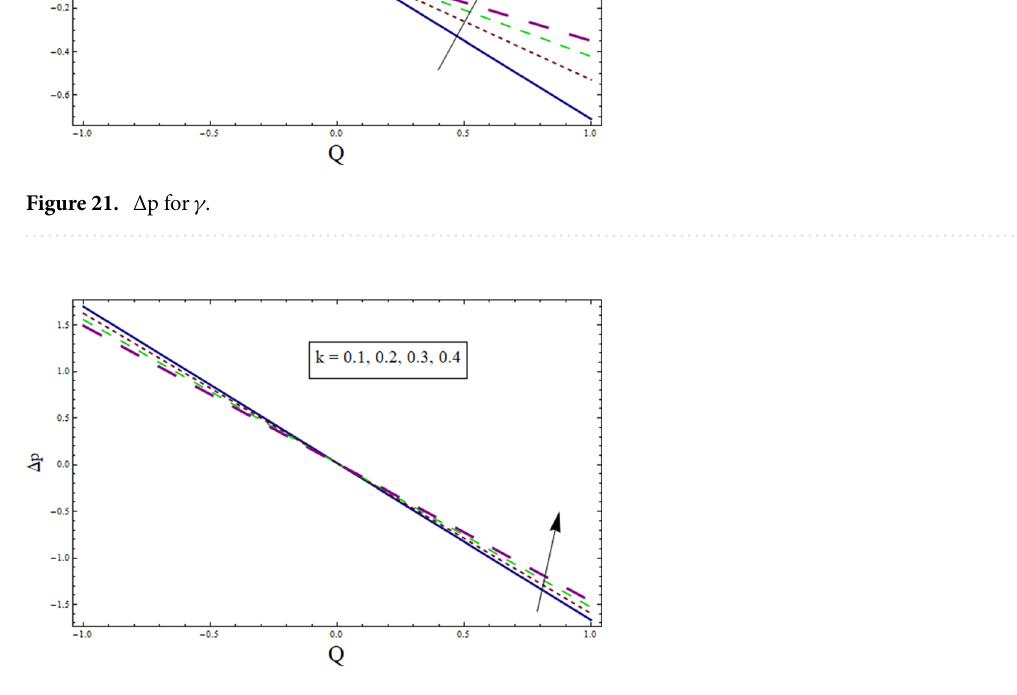
Figure 22. Δp for k